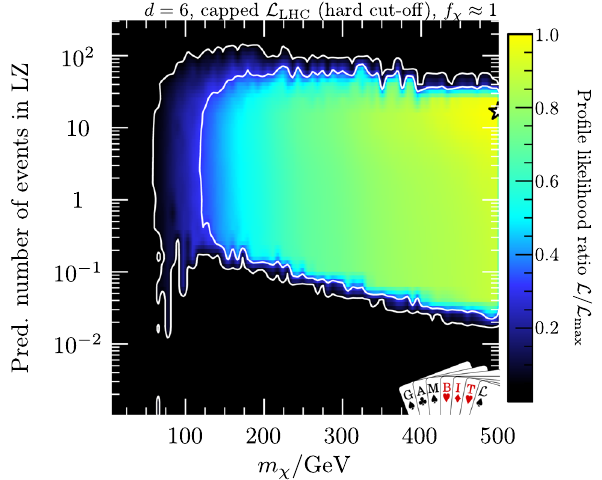
Fig. 6 Profile likelihood in terms of m χ and the predicted number of signal events in the LZ experiment when χ accounts for all of the observed DM abundance (as in Fig.